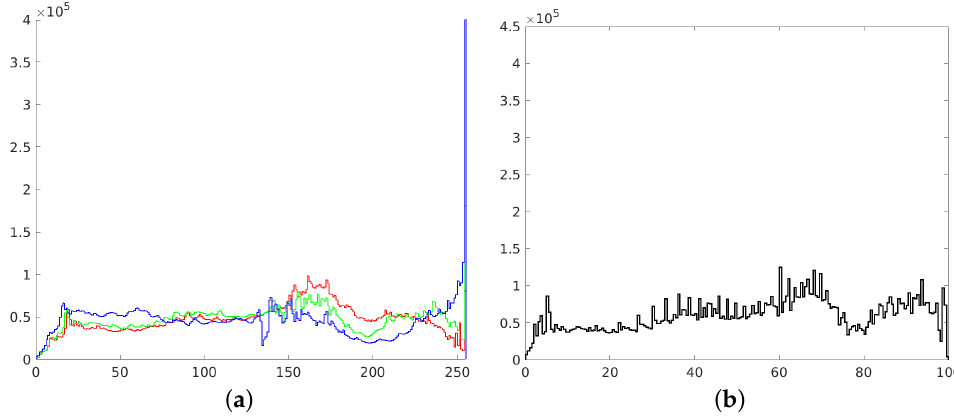
Figure 10. Histograms of RGB channels ( a ) and L channel of L*a*b* space ( b